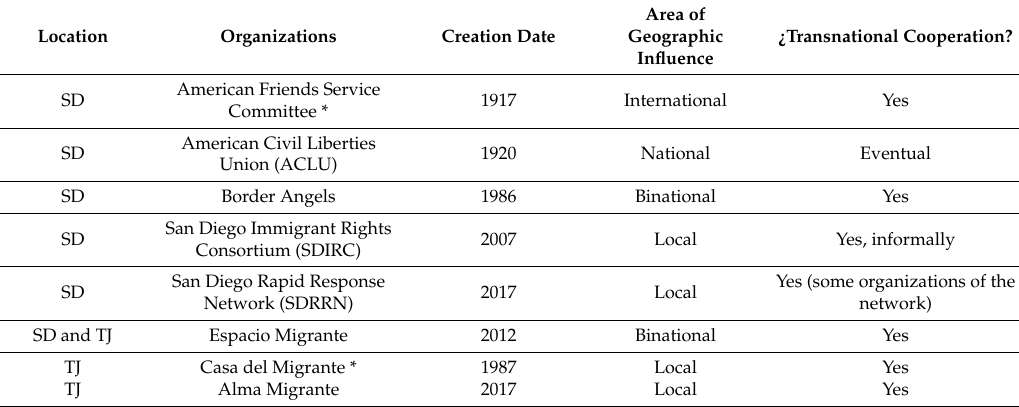
Table 1. Organizations